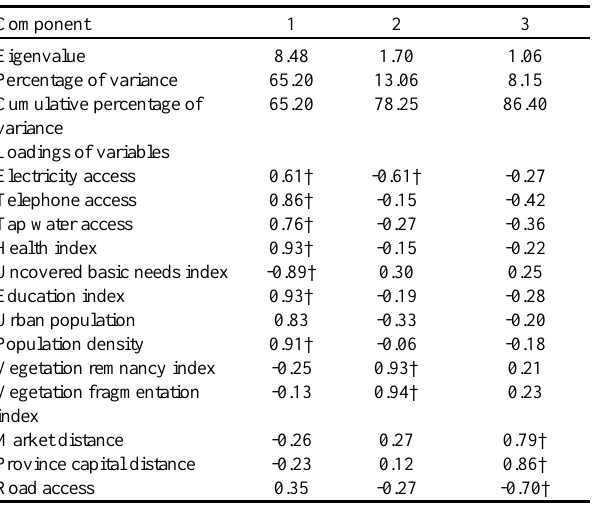
Table 2. Rotated principal components that reduced colinearity among 13 socioeconomic, environmental, and geographical indicator variables of 40 studied localities in